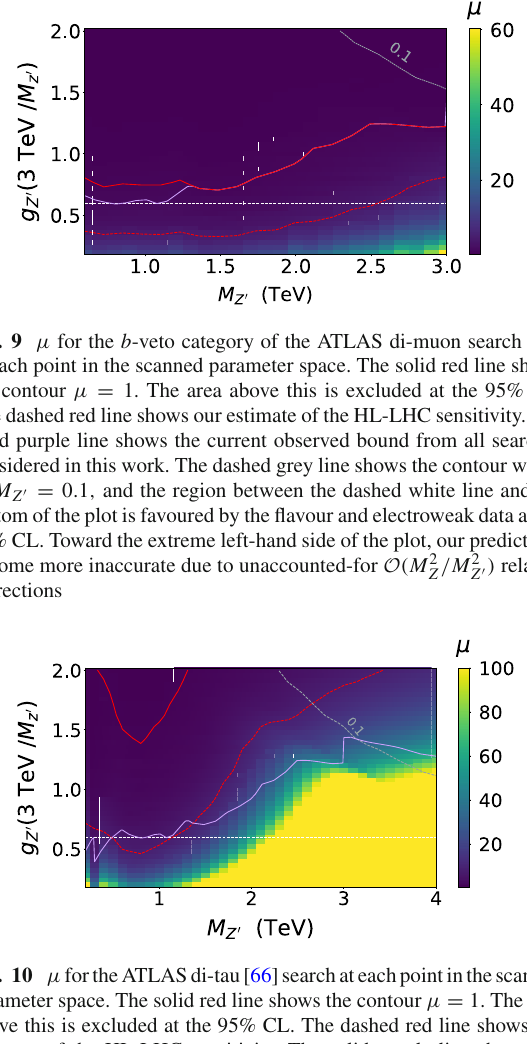
b -tagging requirements in Sect. 2.3 dominate the